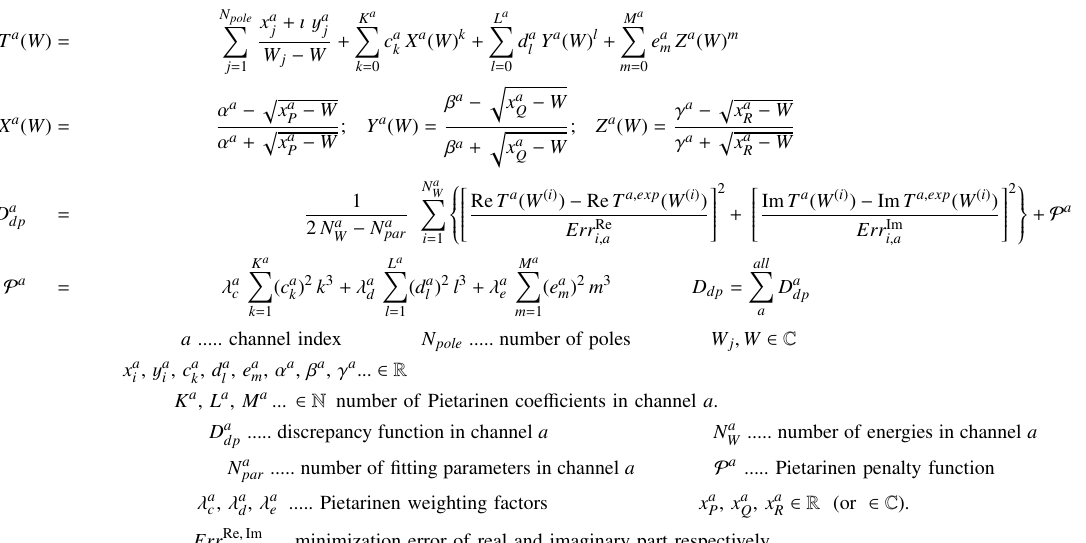
Table 1: Formulae defining the Laurent + Pietarinen (L + P) expansion.